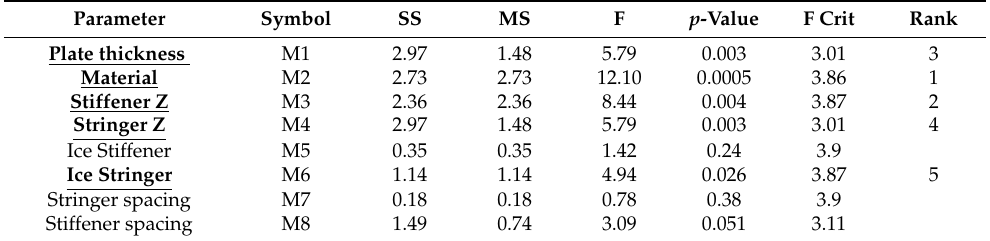
Table 9. ANOVA analysis for metal grillage parameters for SSF. Significant parameters are highlighted in bold and underlined. Order of sensitivity is indicated under rank.